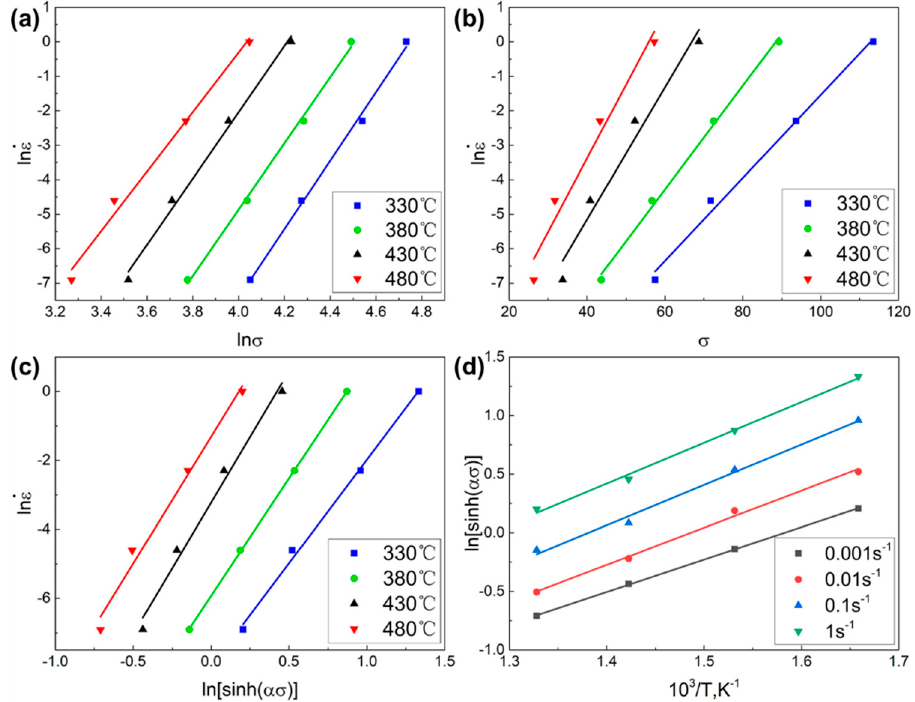
Figure 11. The relationship between the peak stress, strain rate and deformation temperature in the third layer of the deposited alloy: ( a ) ln ε ˙ ‐ ln σ s , ( b ) ln ε ˙ ‐ σ s , ( c ) ln ε ˙ ‐ ln[sinh( ασ )], ( d ) ln[sinh( ασ )] ‐ 1/T.